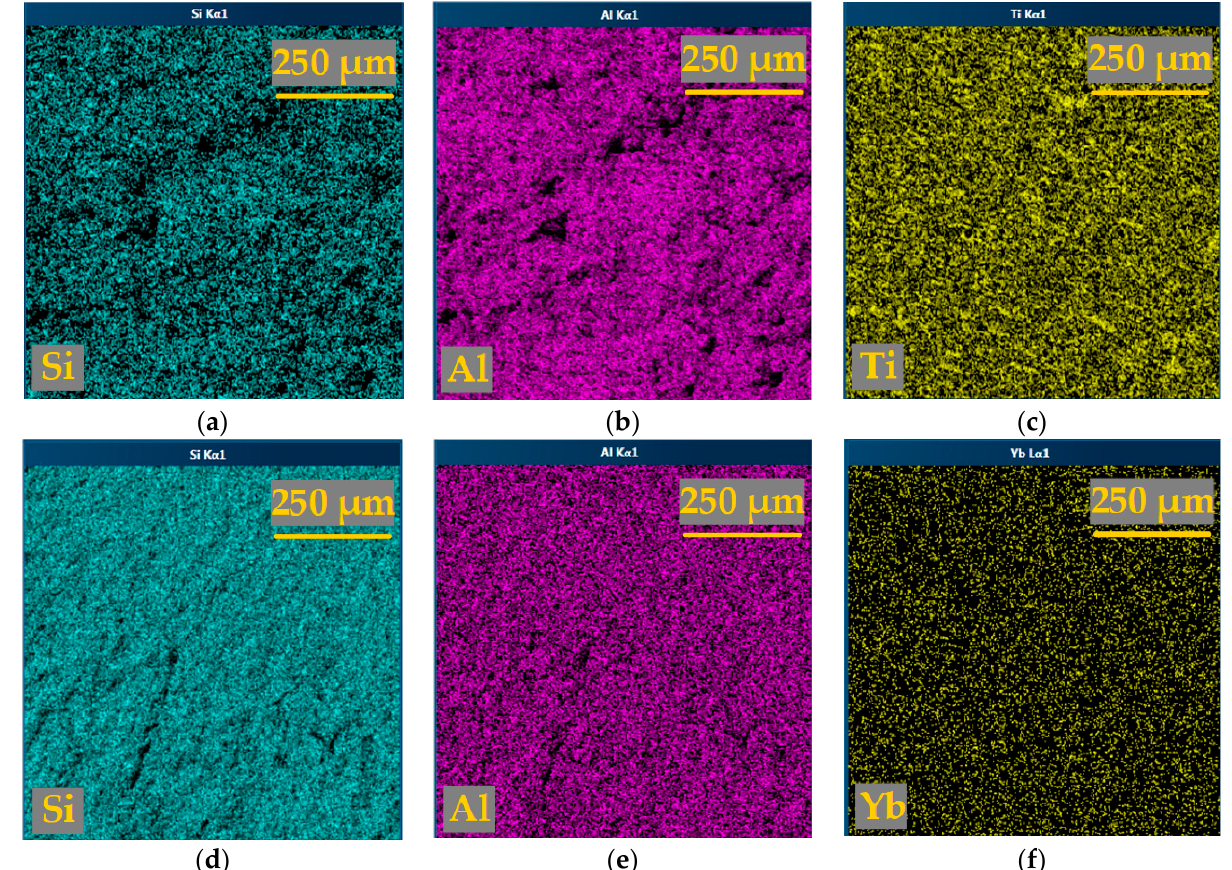
Figure 11. Distribution of chemical elements on the fracture surface of sintered ceramic material based on SiAlON samples, obtained by EDX analysis: ( a ) Si-content of experimental sample 80% (90 α 10 β ) + 20% TiN; ( b ) Al-content of experimental sample 80% (90 α 10 β ) + 20% TiN; ( c ) Ti-content of experimental sample 80% (90 α 10 β ) + 20% TiN; ( d ) Si-content of commercial ceramics specimen; ( e ) Al-content of commercial ceramics specimen; and ( f ) Yb-content of commercial ceramics specimen.